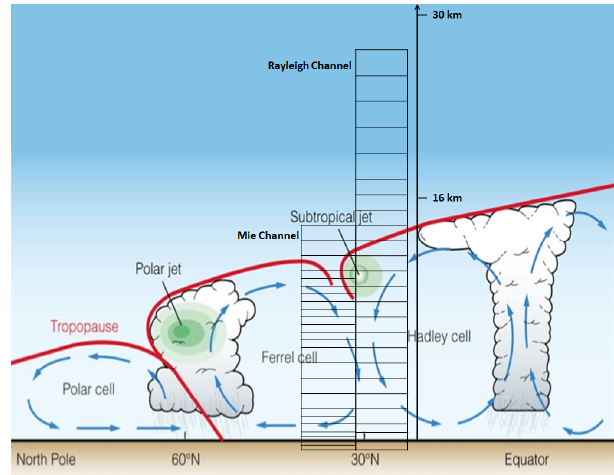
Figure 2. Mie and Rayleigh height bins (©